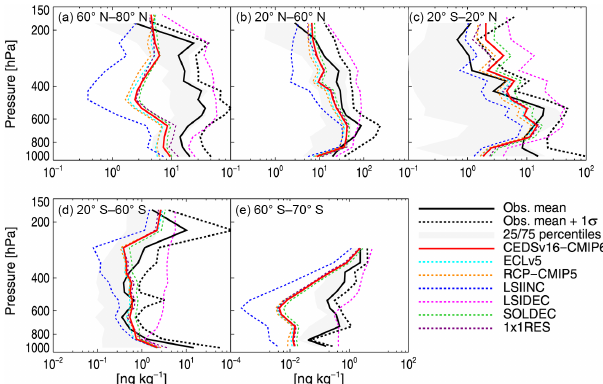
Figure 6. Modeled vertical BC profiles against rBC aircraft mea- surements in five different latitude bands over the Pacific Ocean from the HIPPO3 flight campaign. Model data are extracted along the flight track using an online flight simulator. Black lines show the mean of observations (solid), mean + plus 1 standard deviation (dashed). Colored lines show the Oslo CTM3 baseline (CEDSv16– CMIP6) (solid) and sensitivity simulations